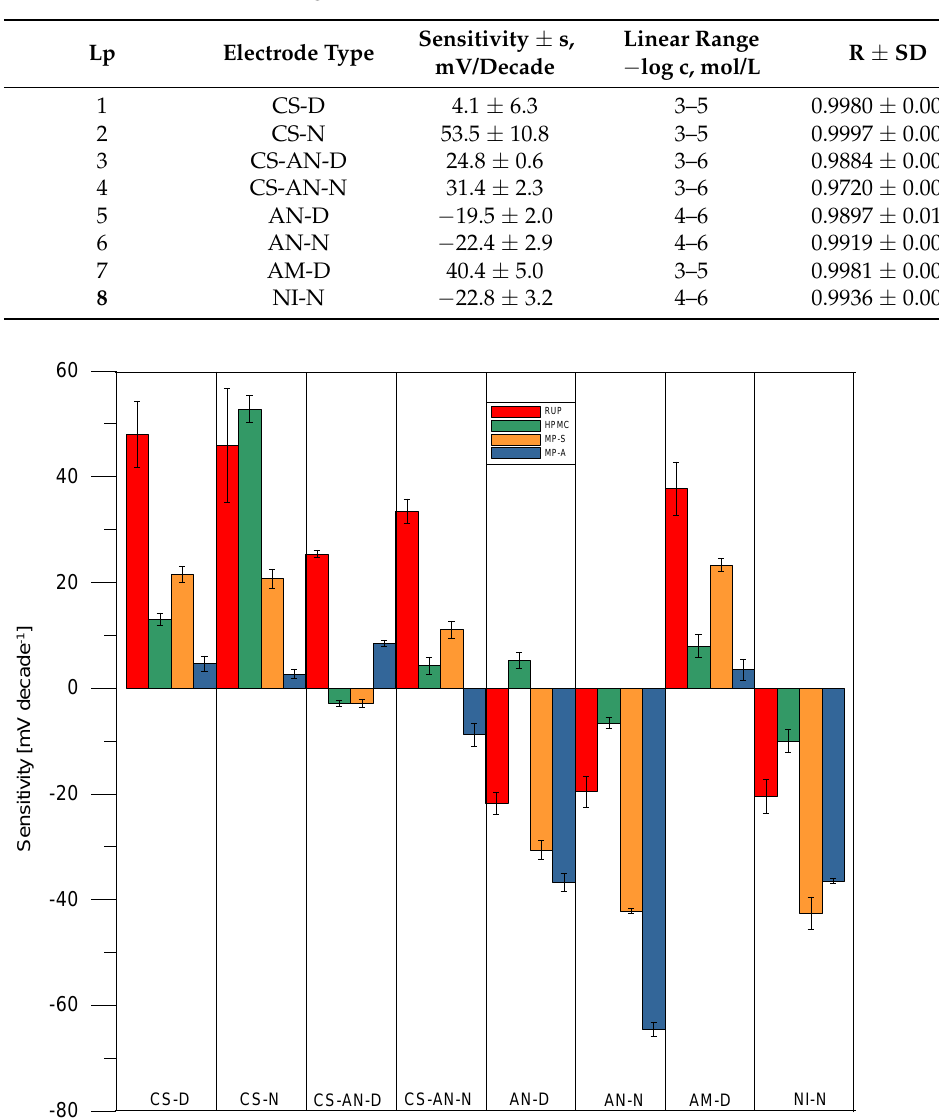
Table 6. Potentiometric working characteristic for 8 electrodes.